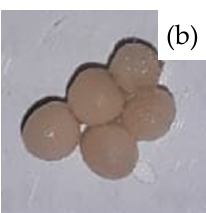
Figure 6. ALDC immobilized in alginate ( a )/gelatin ( b ) particles before and after vacuum drying.